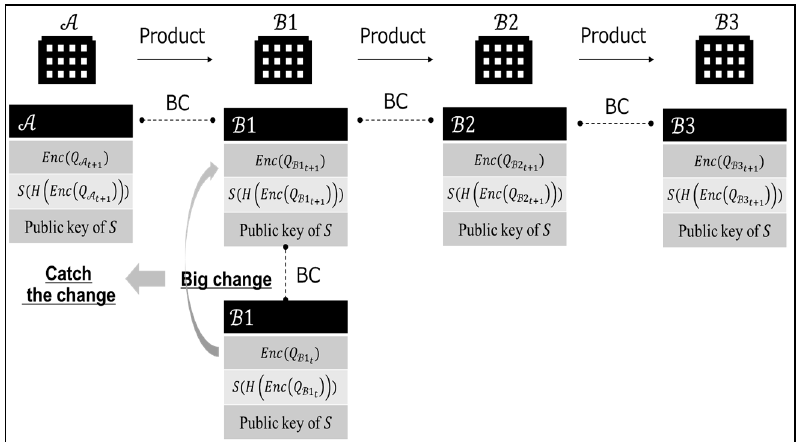
Figure 2. The final system of the B2B collaboration.